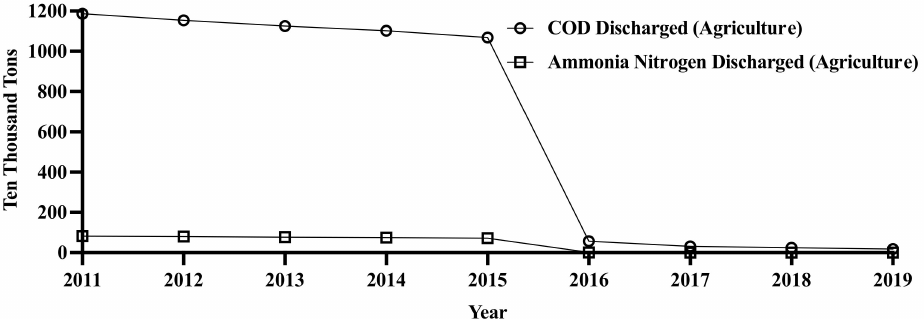
Figure 3. Discharge of agricultural wastewater. Source: China Environmental Statistical Yearbook (2011–2019).